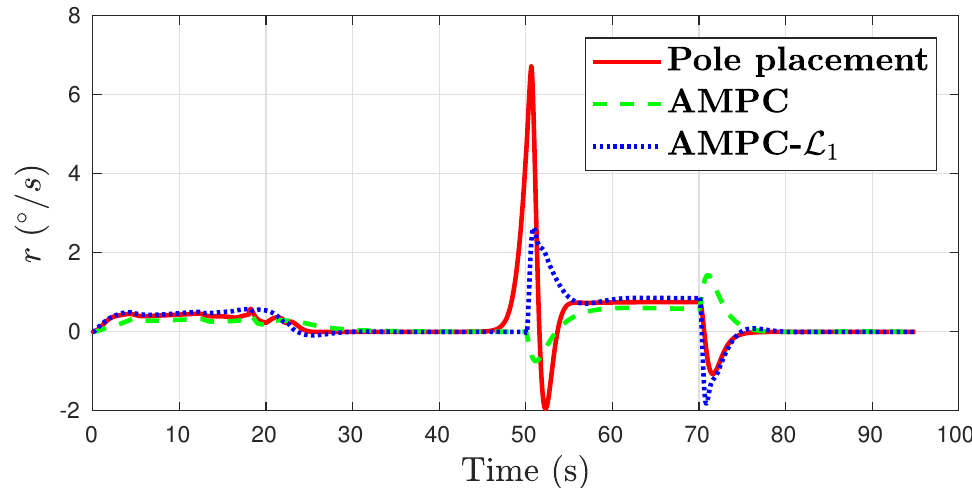
Figure 15. Yaw rate regulation error for guidance uncertainty